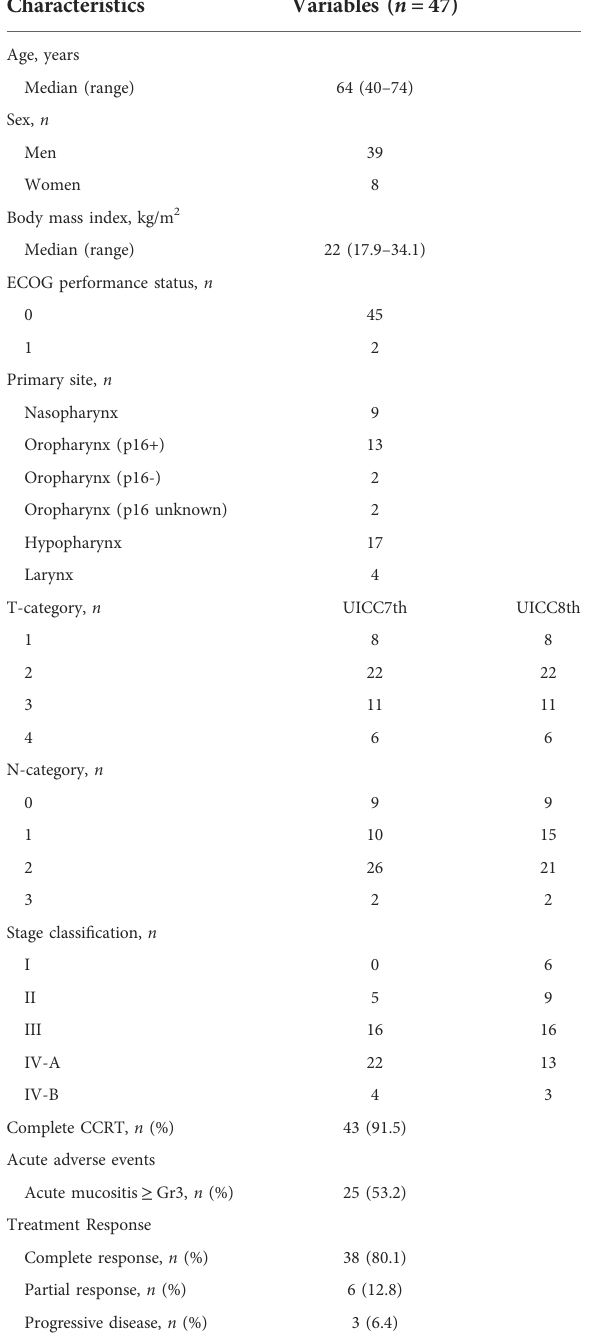
TABLE 1 Characteristics of the patients in the previous phase 2 trial of CCRT with 3-weekly CDDP at a dose of 80 mg/m 2 .